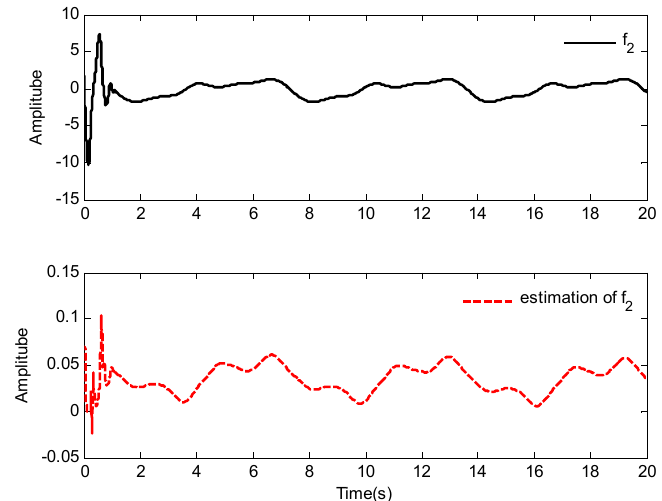
f and f and 1 1